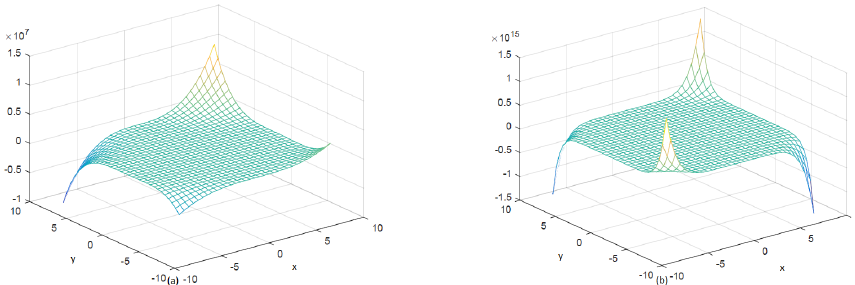
Figure 13: Plotting of (a) M-polynomial and (b) NM-polynomial of